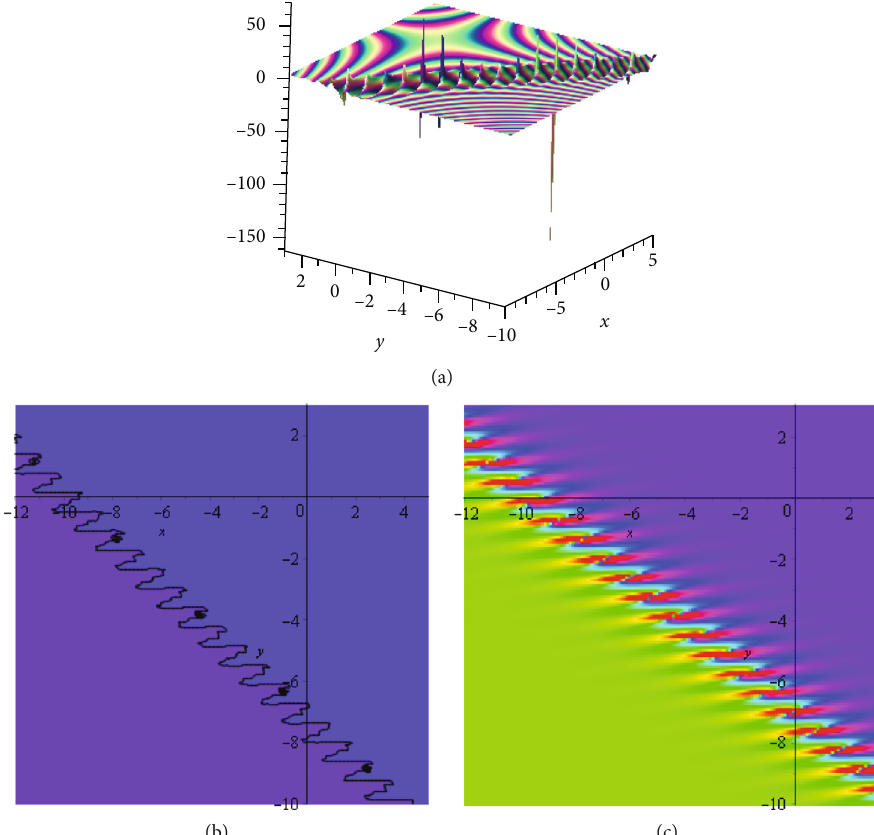
= : 5, a = 1 : 5, a = 2, a = 1, Ω = 1 : 1, Ω = 1 : 5, Ω = 1 : 2, δ = 1, δ = 1 2 3 4 1 2 4 1 2